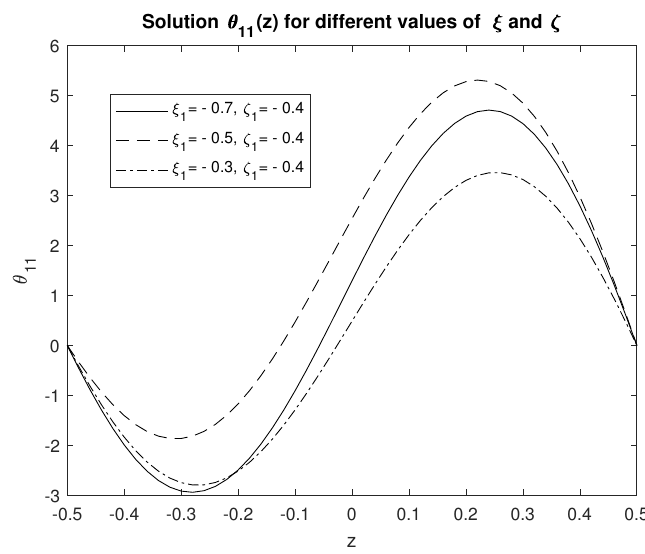
Figure 5. Solutions θ 11 ( z ) for negative ξ 1 .